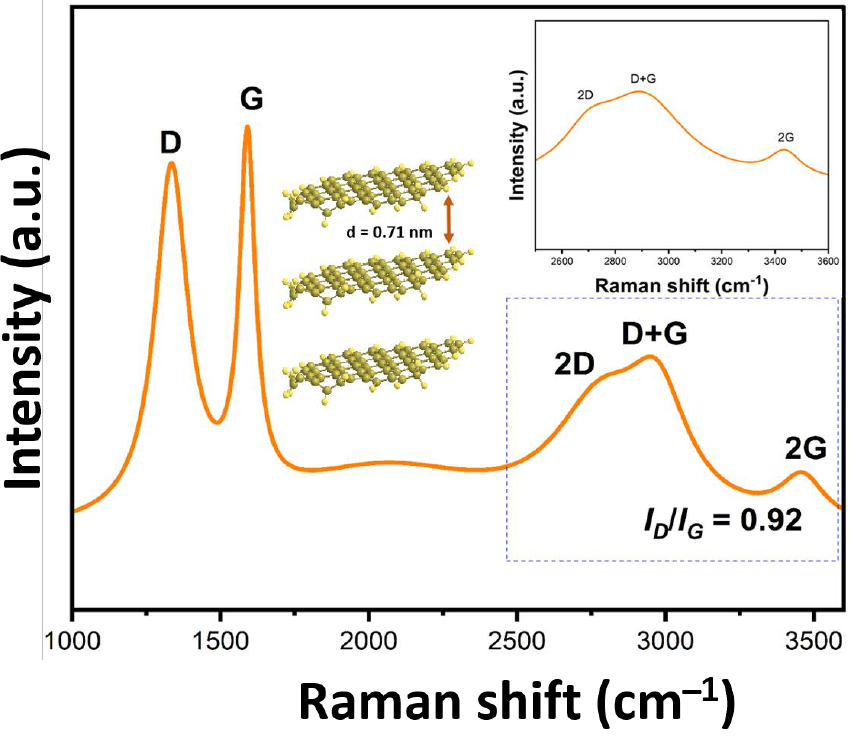
Figure 4. Raman spectrum of GO.